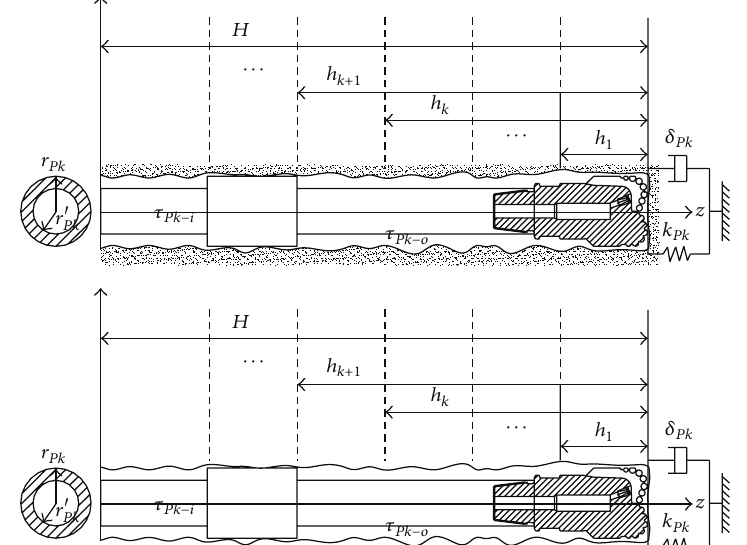
Figure 1: Longitudinal vibration model of drill